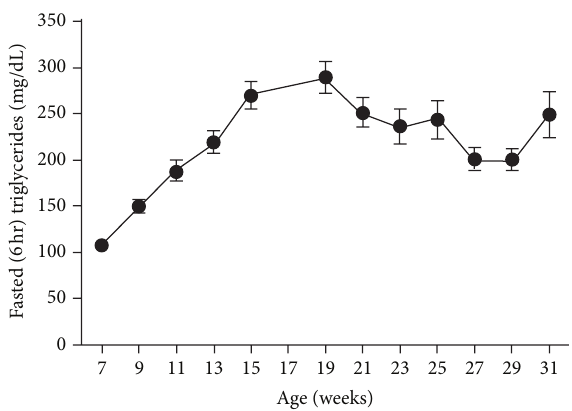
Figure 7: Calculated HOMA- 𝛽 in male ZDSD rats throughout the study duration of rats in ages from 7 to 31 weeks (mean ± SEM, 𝑛 = 23 ).